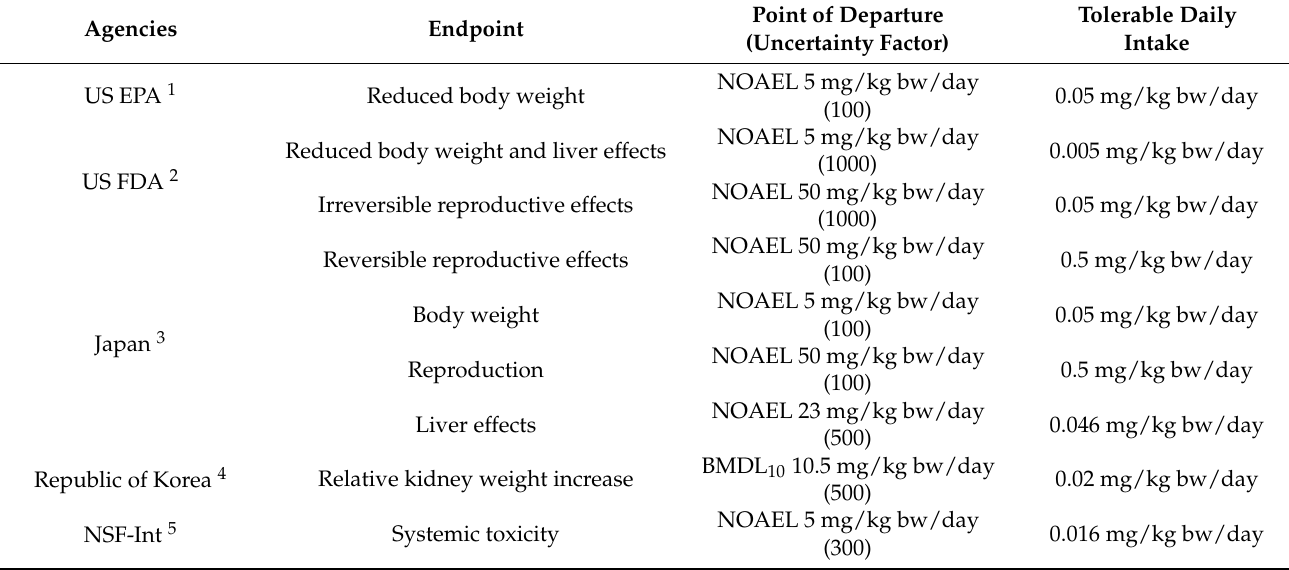
Table 1. Various international health-based guidance values of bisphenol A